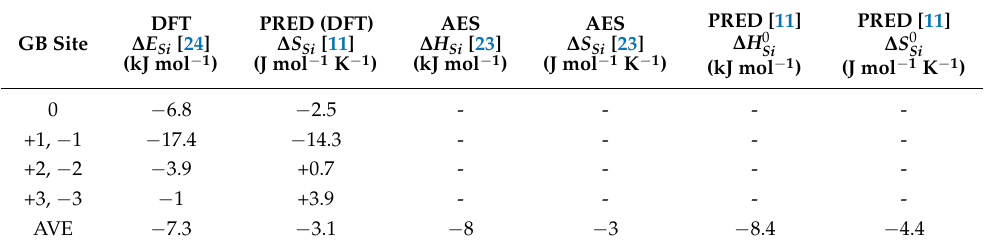
Table 1. The average values of ∆ H 0 and ∆ S 0 obtained experimentally [23] as well as on basis of Si Si prediction [11], and the values of ∆ E Si , k calculated for individual sites [24], all corresponding to the {013} grain boundary of bcc Fe. Values of ∆ S Si , k corresponding to individual ∆ E Si , k were estimated on basis of model [11] (Equation (4)). AES, experimental data; GB site, site according to [24]; PRED, prediction [11]; AVE, average; ∆ E Si AVE, average of calculated segregation energies determined according to Equation (9) with ξ k = 1 and P =